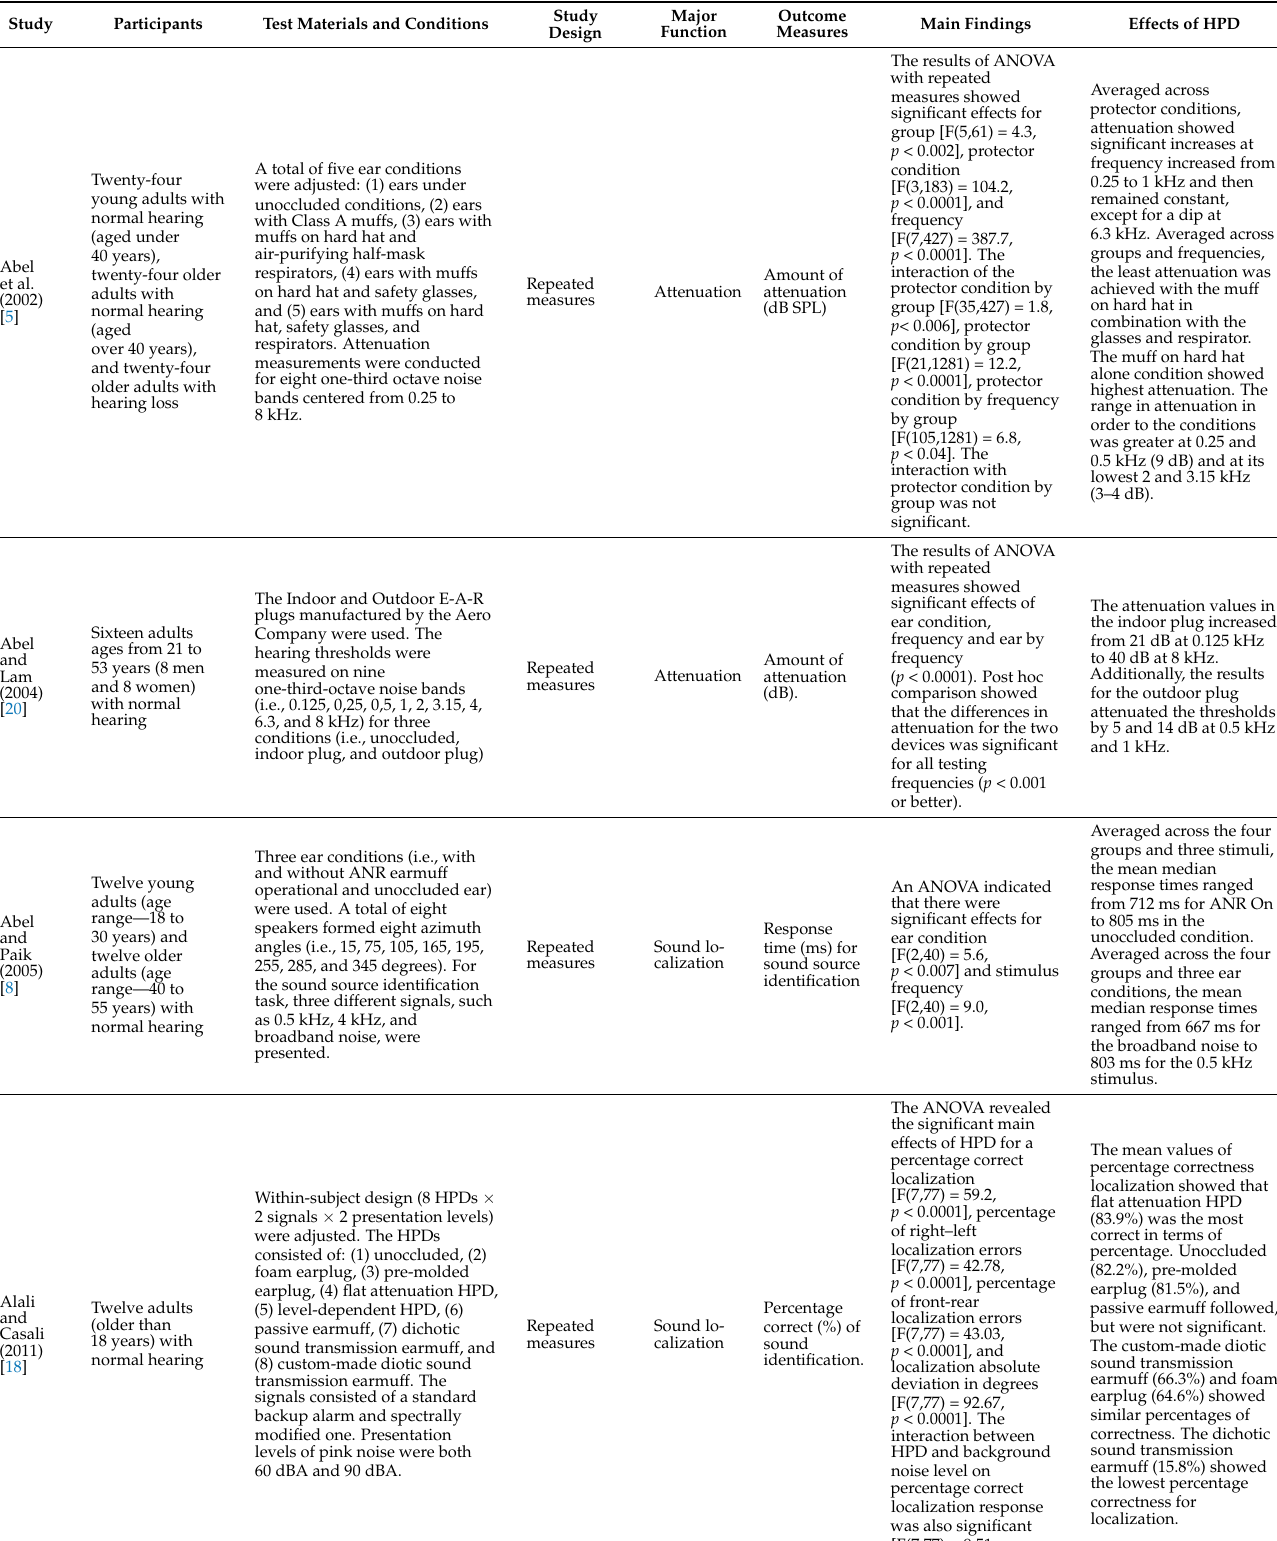
Table 3. Characteristics and effects of hearing protection devices for all enrolled studies for the participants, intervention, control group, and outcome of each